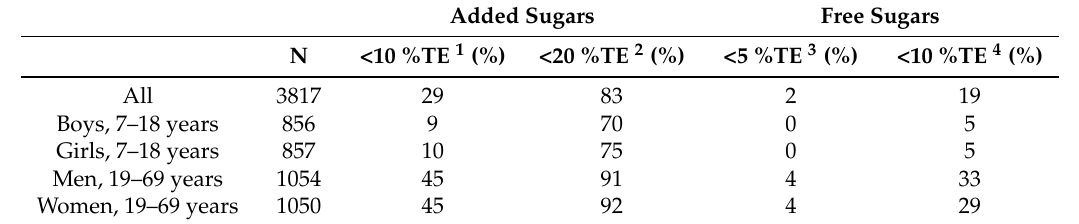
Table 3. Adherence to recommendations of added and free sugars (%) in 3817 participants from the Dutch National Food Consumption Survey 2007–2010.